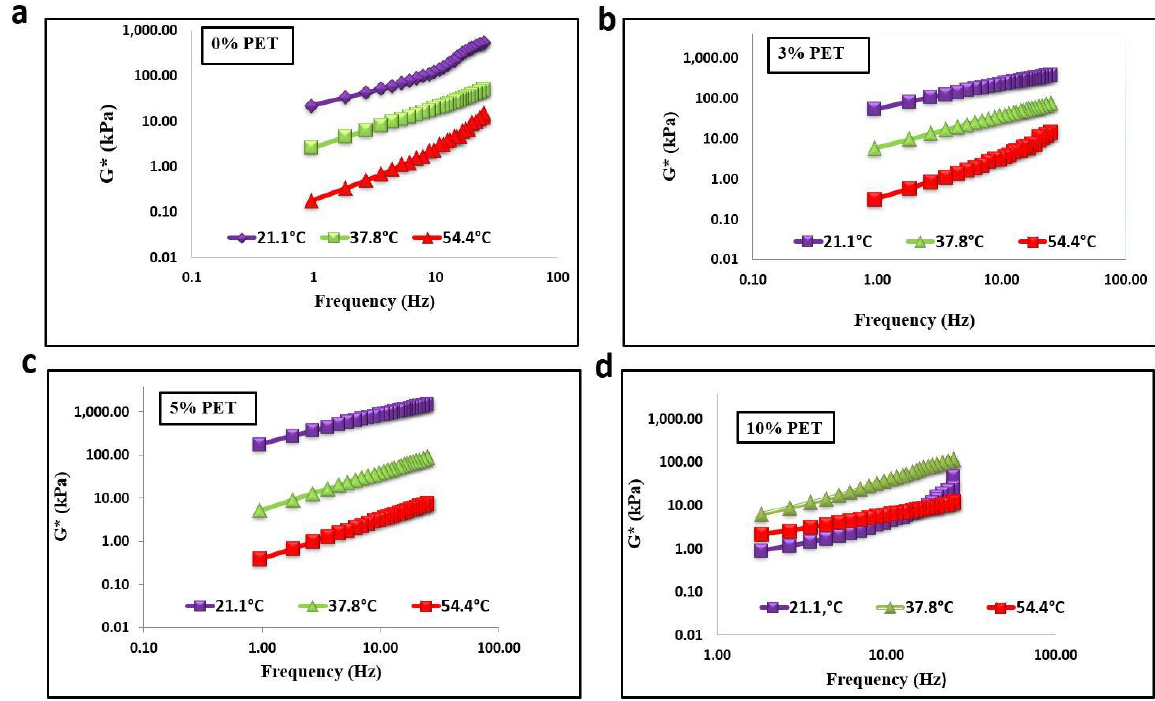
Figure 7. Isothermal plots of unaged binder with PET content of ( a ) 0%, ( b ) 3%, ( c ) 5%, and ( d ) 10%.